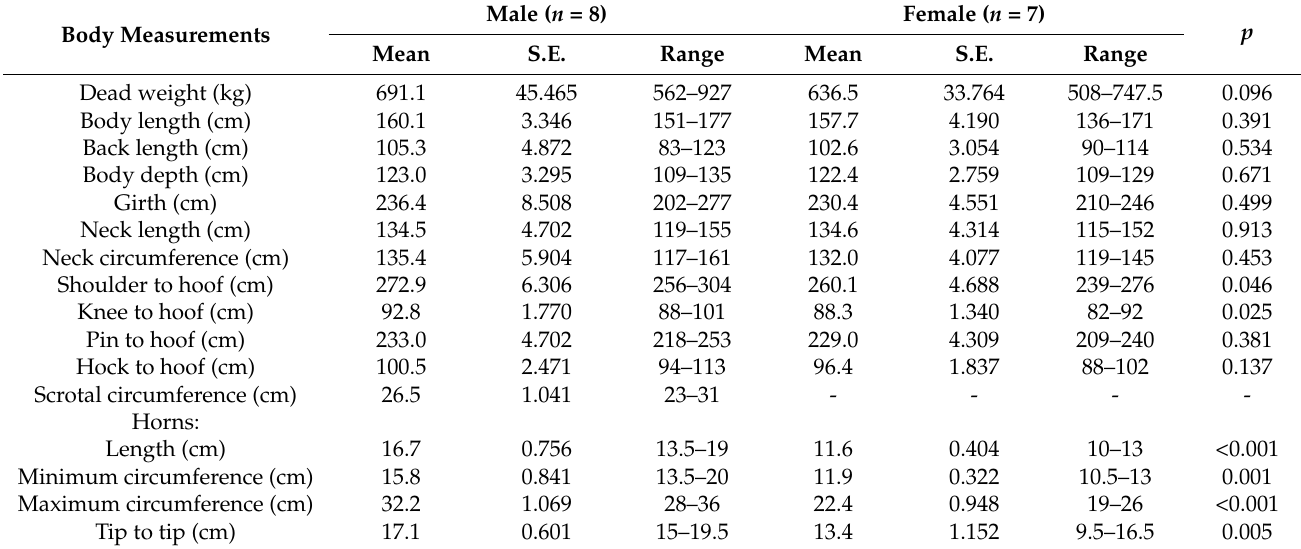
Table 1. Body and horn measurements of ~3.7 year-old male and female giraffe ( G. c. angolensis ). Body